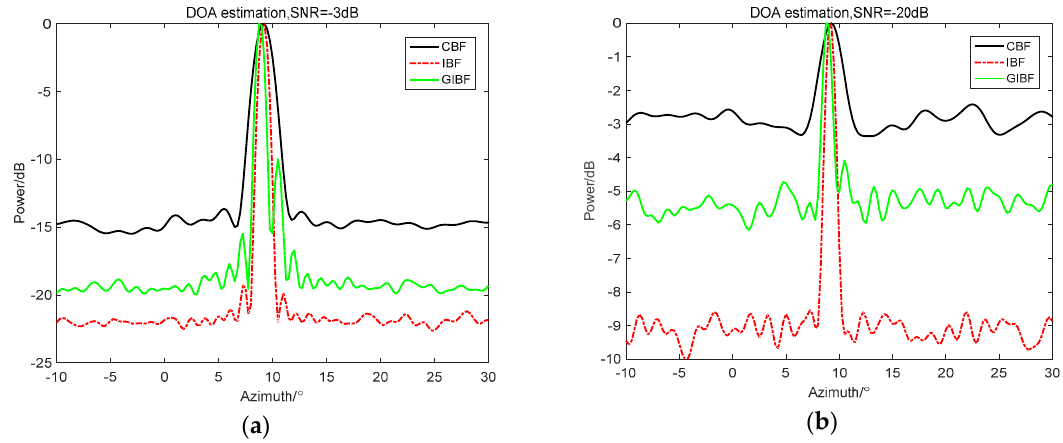
Figure 5. Comparison between CBF, IBF, and GIBF under different SNRs: ( a ) − 3 dB; ( b ) − 20 dB.